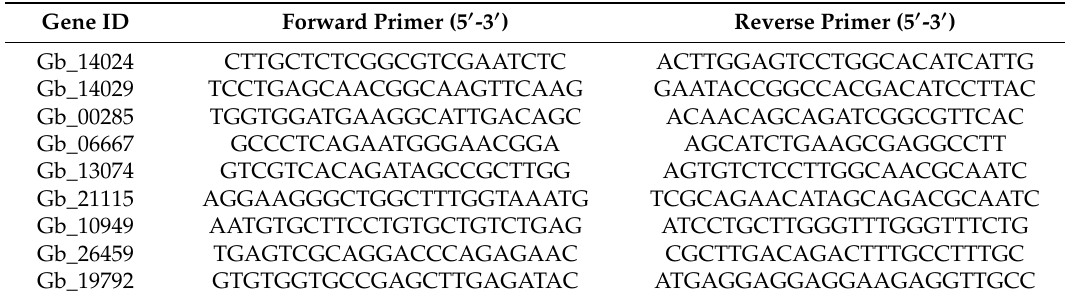
Table 1. Primers used for a subset of DEGs in this